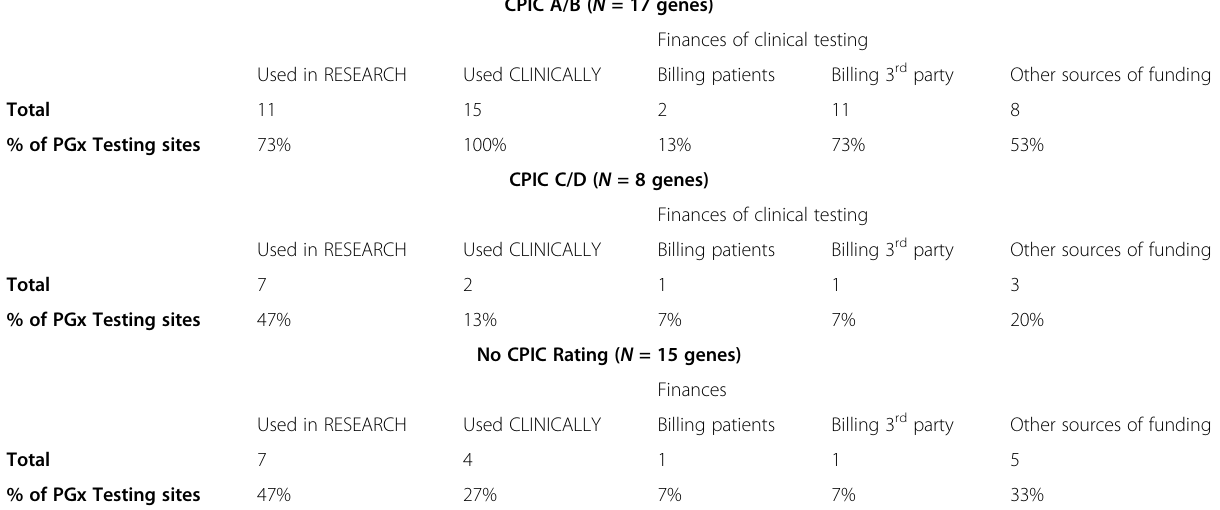
Table 2 CPIC Rating and IGNITE Member Sites Using pharmacogenomics testing for Research, Clinical Reporting and Billing/ Reimbursement Methods ( N =